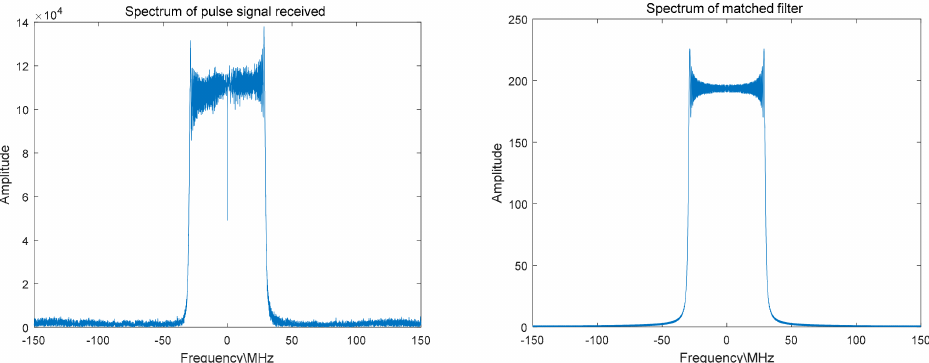
Figure 8. Spectrum of one of the pulse signals and the constructed matched